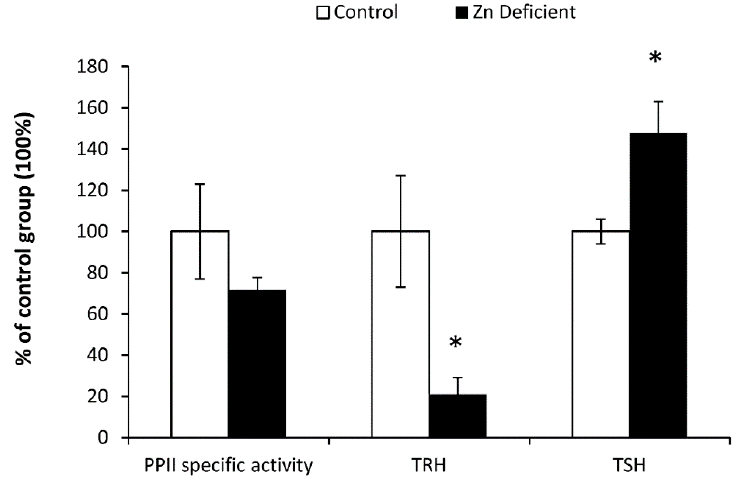
Figure 2. Adenohypophyseal pyroglutamyl aminopeptidase II (PPII) specific activity, median eminence thyrotropin-releasing hormone (TRH) content and thyrotropin (TSH) serum levels of Zn-deficient and control pups at weaning. Control values for PPII specific activity: 631.2 ± 194 pmol β NA/min/mg prot; TRH: 22.36 ± 6.2 ngTRH/mg proteins; TSH: 1.66 ± 0.1 ng/dL. Values are the mean ± SEM of percentage of control values (=100%), ( n = 6/group).* p < 0.01 vs. controls.